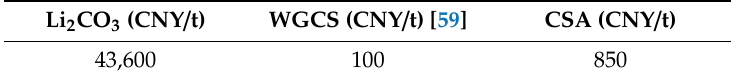
Table 7. Cost of the materials.